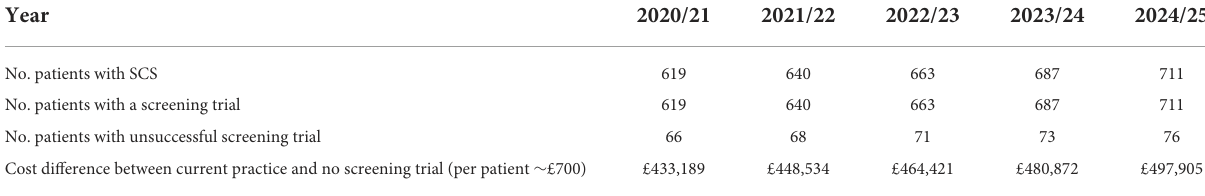
TABLE 3 Difference in current practice and a no screening trial strategy from 2020/21 to